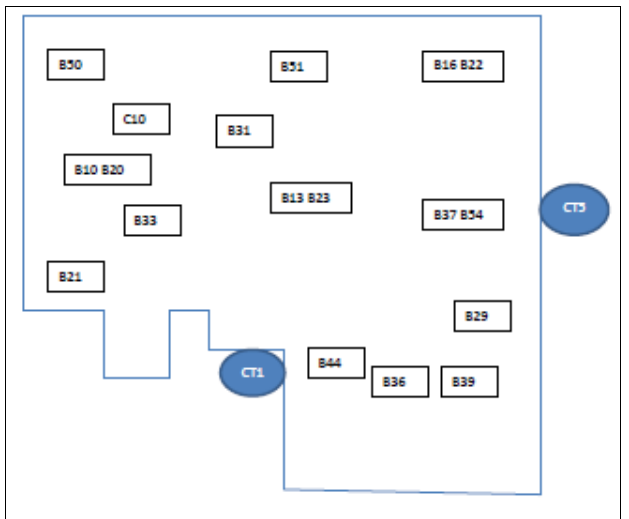
Figure 2. Schematic of Factory 1, showing most of sample points. CT1 and CT5 = cooling towers where samples were also taken.